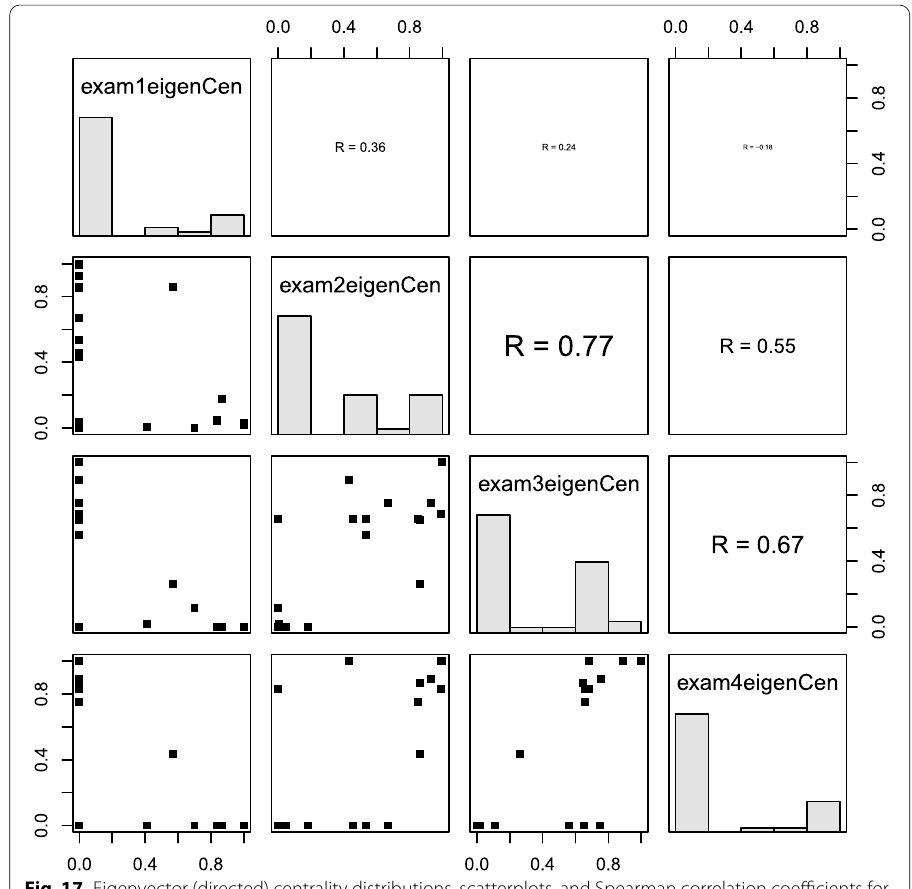
Fig. 17 Eigenvector (directed) centrality distributions, scatterplots, and Spearman correlation coefficients for the Spring 2016